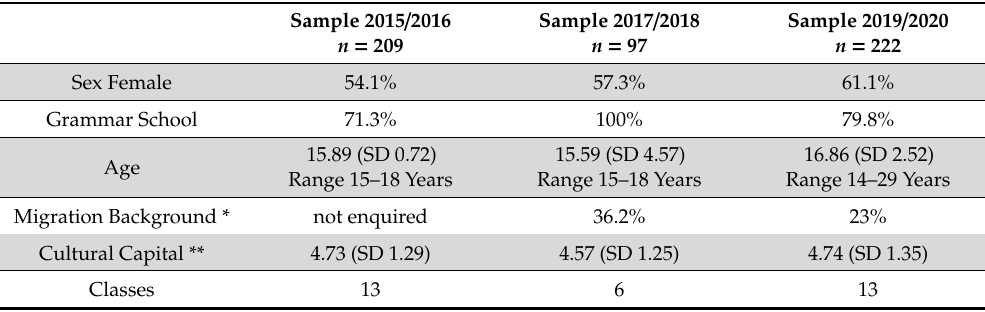
Table 1. Pretest-Posttest Sample Description for All Three Evaluation